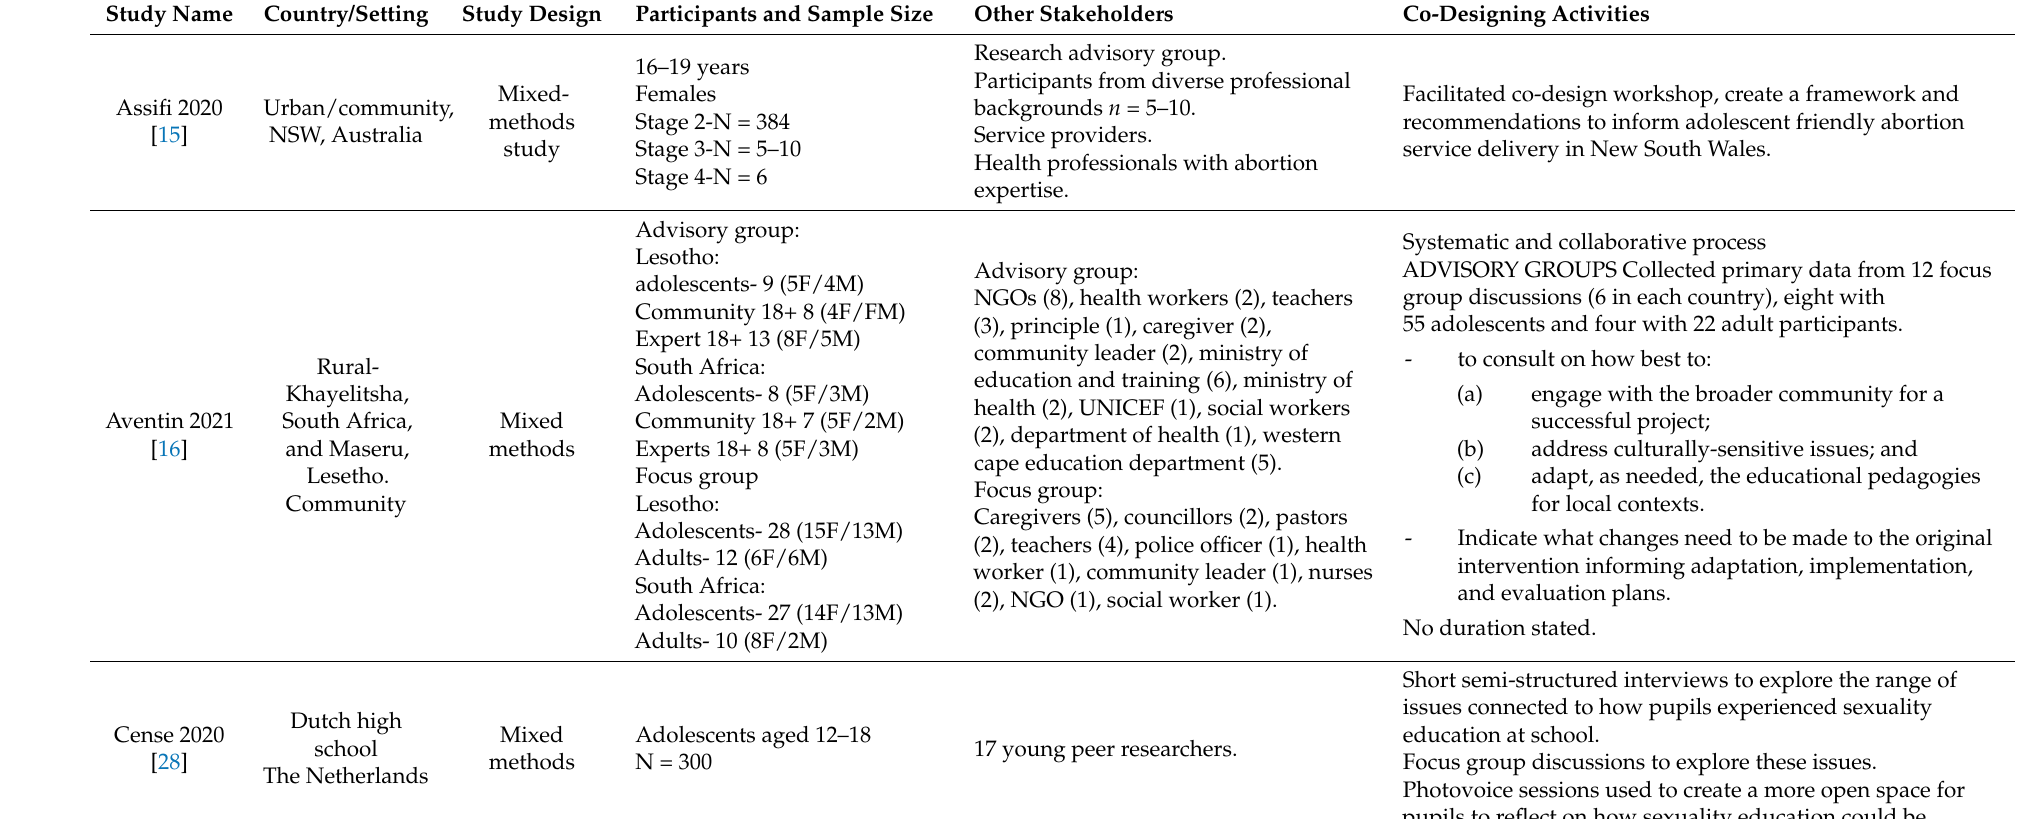
Table 1. Characteristics of included